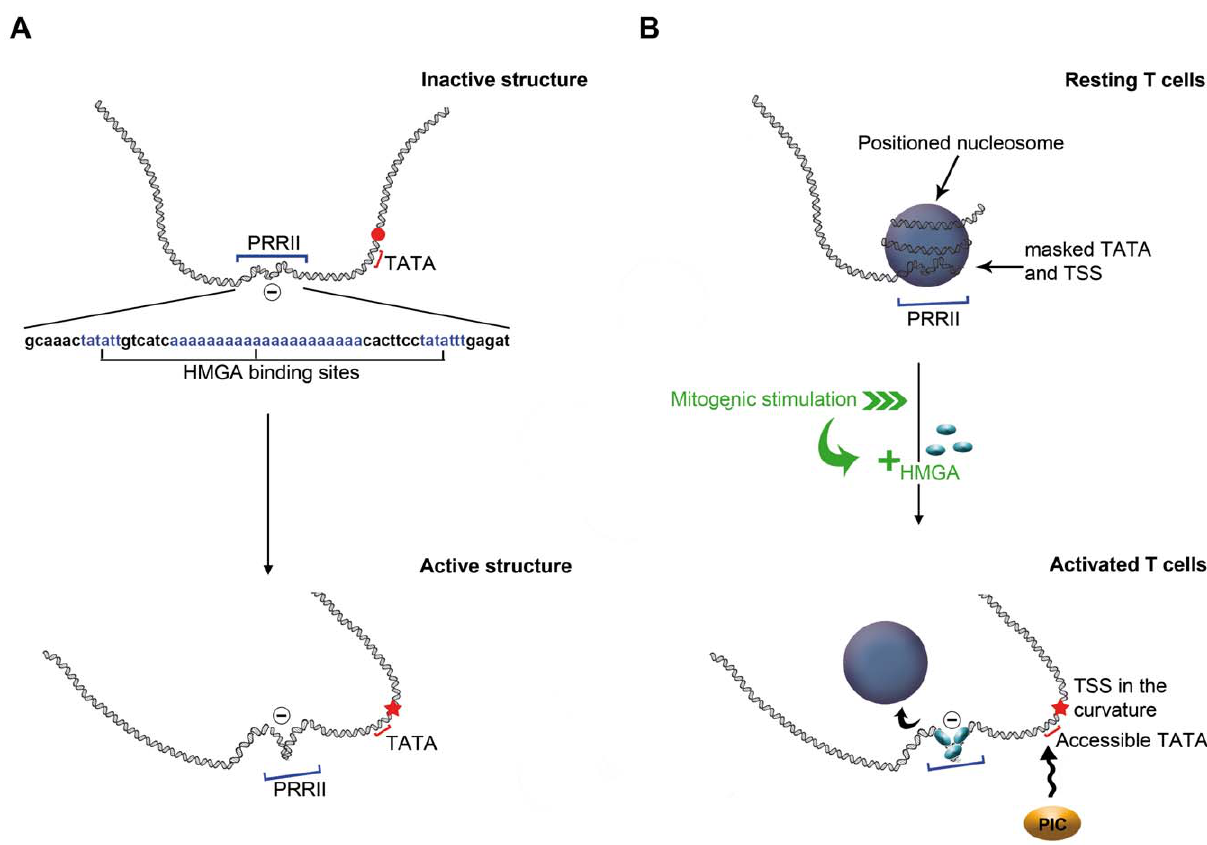
Figure 4. Tentative model for the activation of IL2RA gene expression. (A) Schematic representation of structural changes induced by the dynamics of a negative supercoil (circled minus) in a region containing the PRRII element (blue bracket) on naked DNA. The supercoil twisting (or DNA untwisting) allows the repositioning of the TSS from a straight portion keeping it closed (red dot), to the curvature apex of the molecule, thus favoring the melting of this region (red star). A red bracket indicates the position of the TATA box. (B) Model of the IL2RA promoter before (resting cell) and after (activated T cells) activation. The upper panel depicts the centrally positioned nucleosome masking part of PRRII (blue bracket), the TATA box and the TSS region, preventing both the PIC formation and Elf-1 binding, and keeping closed the TSS region. After activation, the binding of three HMGA molecules on PRRII induces a negative torsional stress that contributes to the remodeling and/or the ejection of the nucleosome, and allows the binding of the PIC and of Elf-1 on the TATA box (red bracket) and PRRII, respectively (lower panel). The TSS ( + 1, red star) is at the DNA curvature apex.